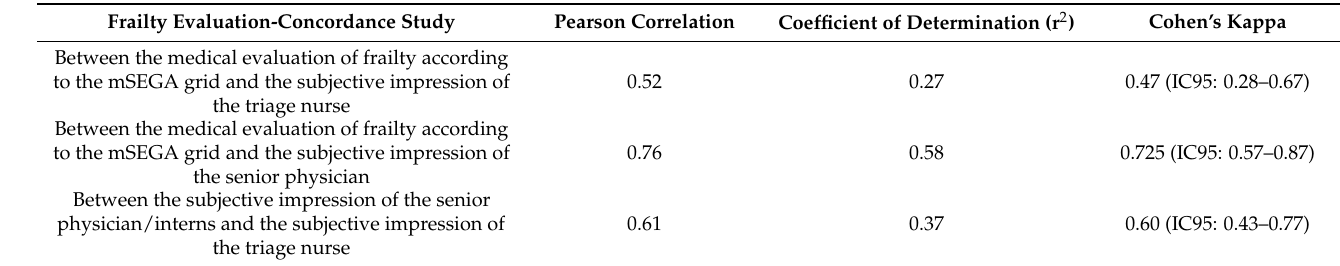
Table 4. Concordance